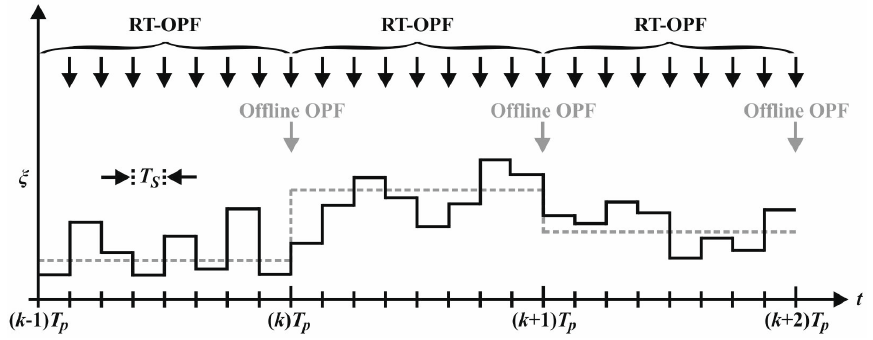
Figure 1. Offline optimal power flow (OPF) (gray) and real-time (RT)-OPF (black).